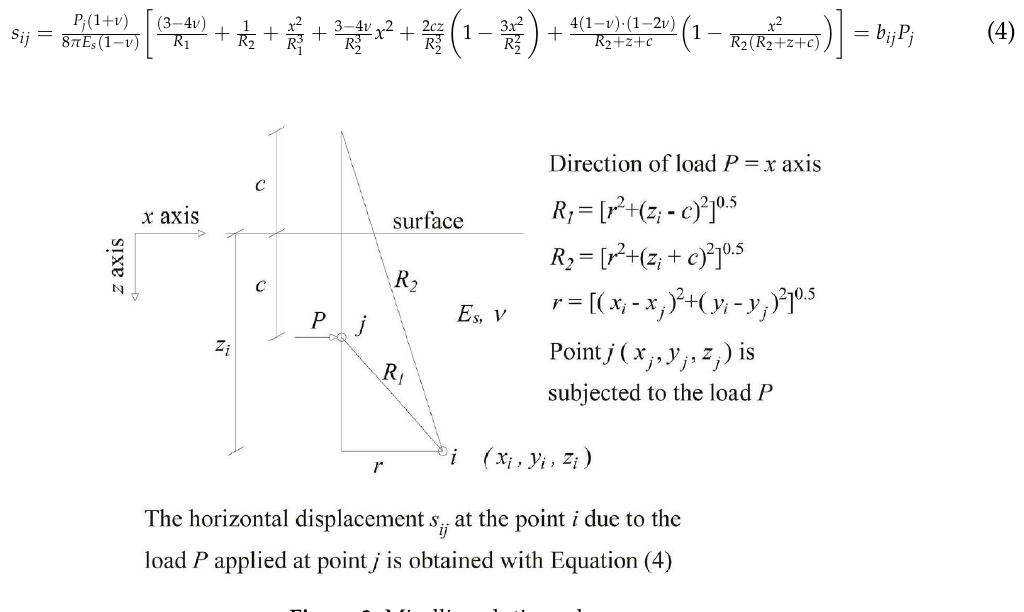
Figure 3. Mindlin solution scheme.